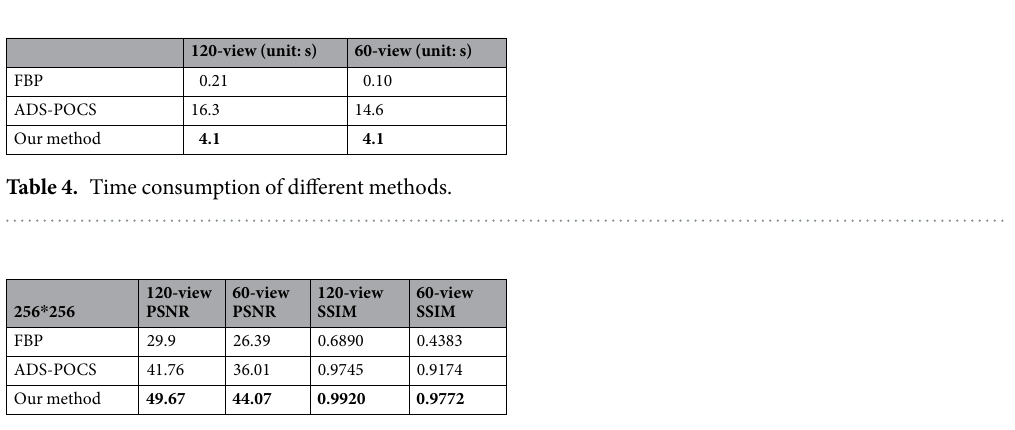
Table 5. Average values of PSNR and SSIM between proposed method and full-view FBP reconstruction for 256 * 256 CT